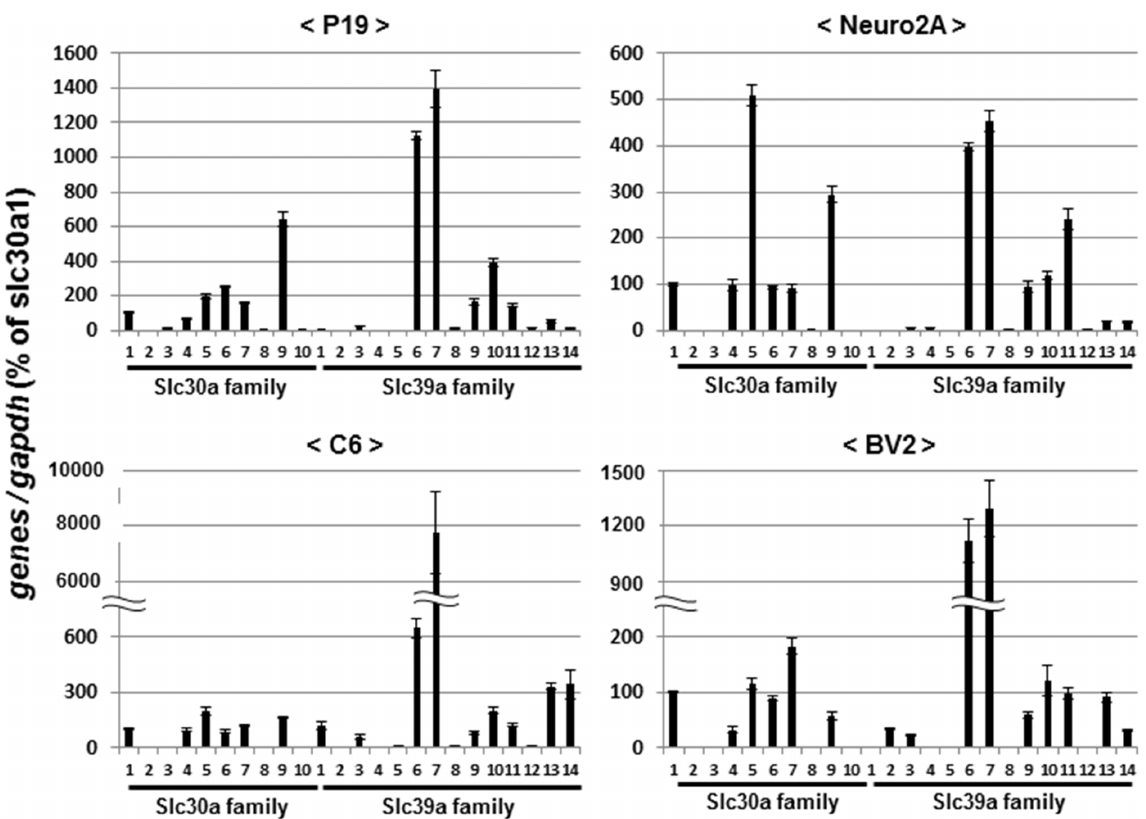
Fig 17. Expression profiles of Zn 2+ transporters in different cell lines. Cells were cultured under respective appropriate conditions, followed by extraction of total RNA and subsequent determination of mRNA expression on qPCR. Values are the mean ± S.E. of percentages over the expression of Slc30a1 in 3 different